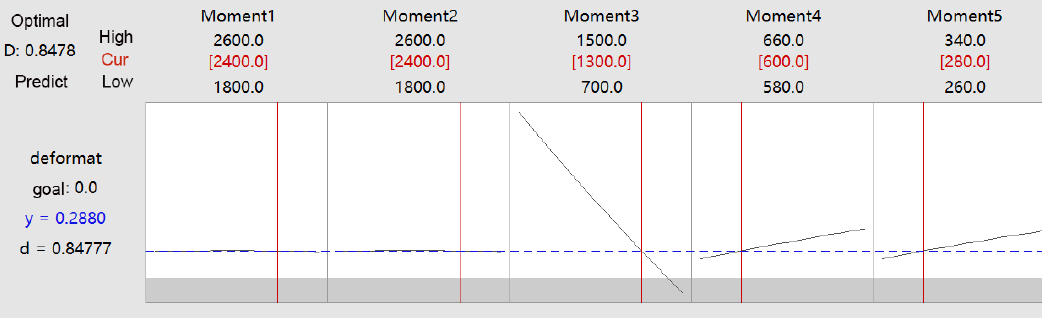
Figure 13. Response optimizer optimization diagram of excitation design. Table 5. Response optimizer optimization results of excitation design.